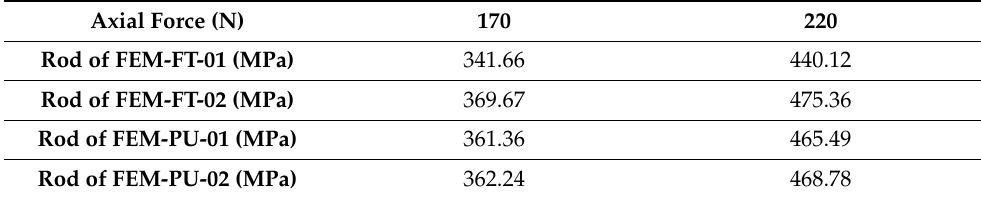
Figure 4. The distribution of the maximum von Mises stress on ( a ) pedicle screws of four models and ( b ) rods of the FEM-FT-01 model under 170 N axial loading. Table 5. Maximum von Mises stress on